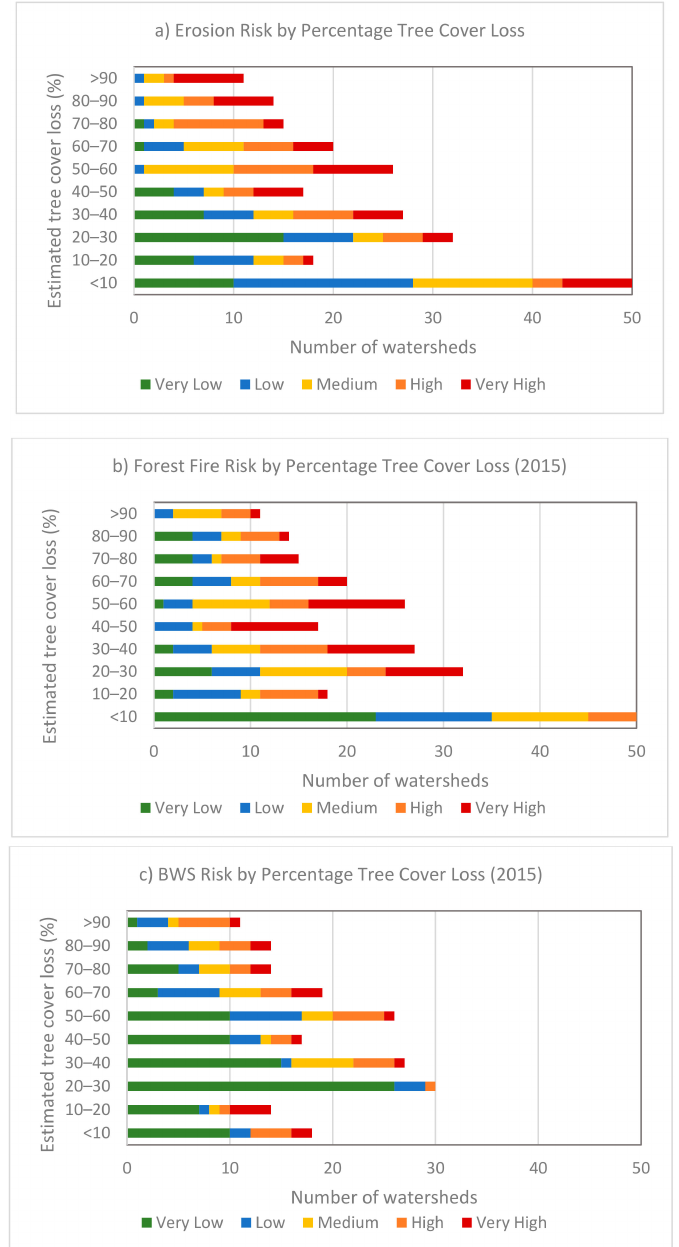
Figure 4. Potential relationship between ( a ) tree loss and erosion risk, ( b ) forest fires and ( c ) baseline water stress (BWS). Data sourced from WRI (2017)